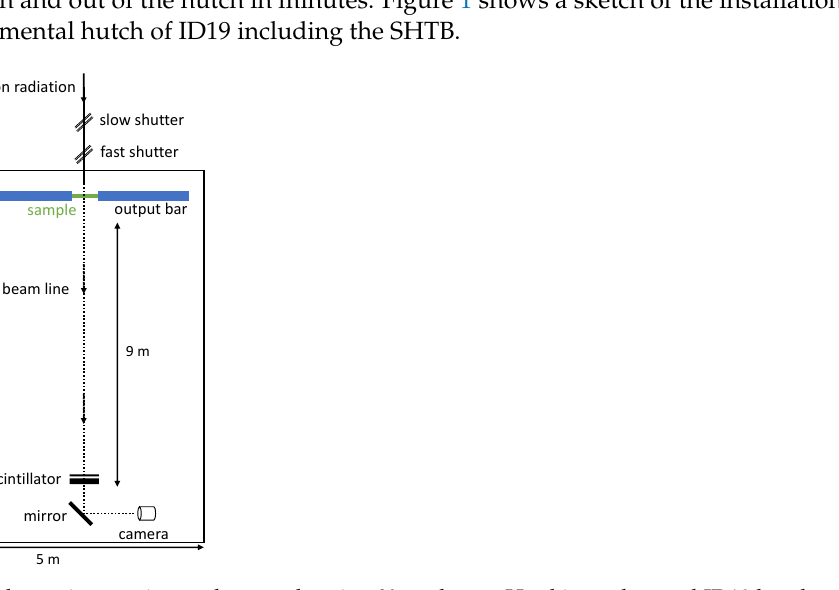
Figure 1. Schematic experimental setup showing-X-ray beam, Hopkinson bar and ID19